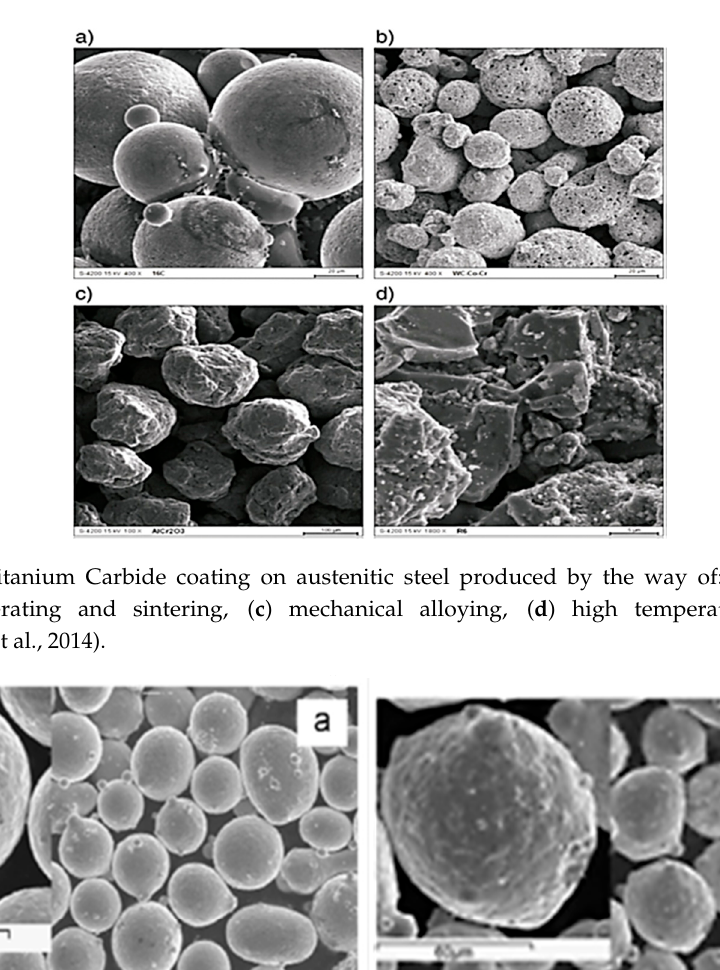
Figure 8. Microstructure of powder feedstock: a ) NiCrCoAlY and b ) CoNiCrAlY (Pereira et al., 2015).